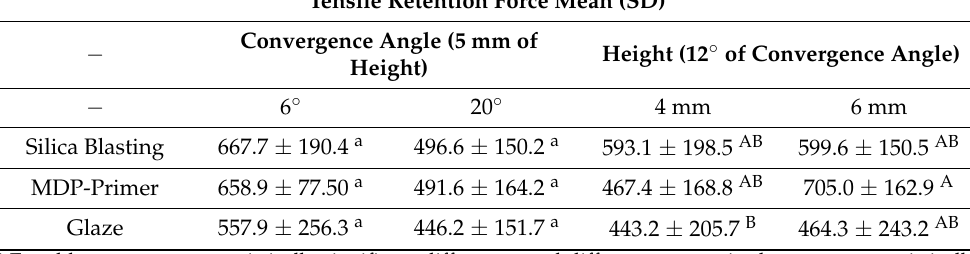
Table 1. Mean (N), standard deviation and homogeneous groups (Tukey test, p < 0.05) comparing the surface treatments and convergence angles and comparing the surface treatments and prepara- tion